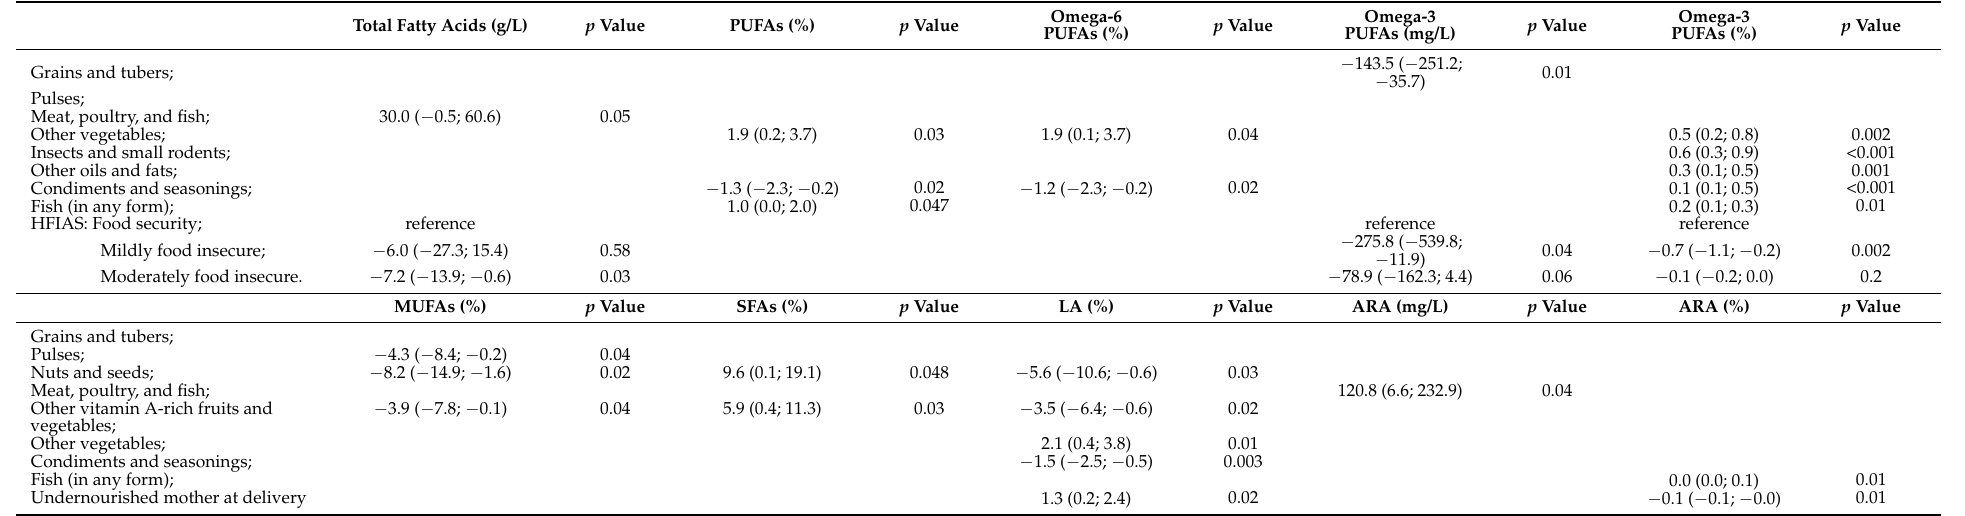
Table 5. Multilevel models of the dietary determinants of human milk fatty acids during the first 6 months of life (1).